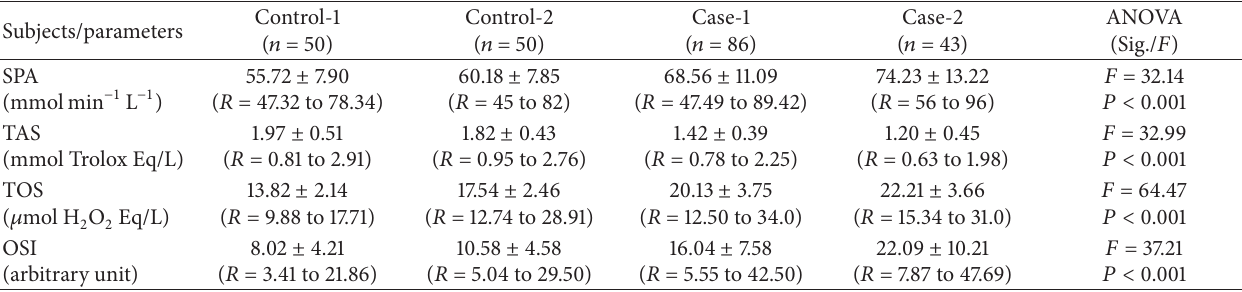
Table 2: Representation of SPA, TAS, TOS, and OSI for cases and controls. Subjects/parameters